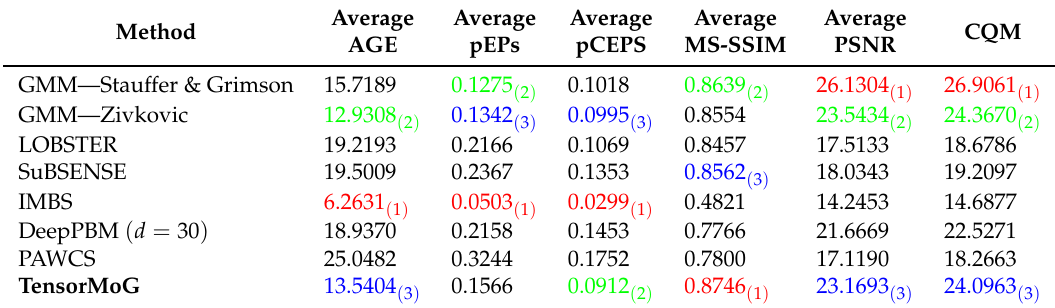
Table 6. Comparison on the Scene Background Initialization (SBI) dataset.